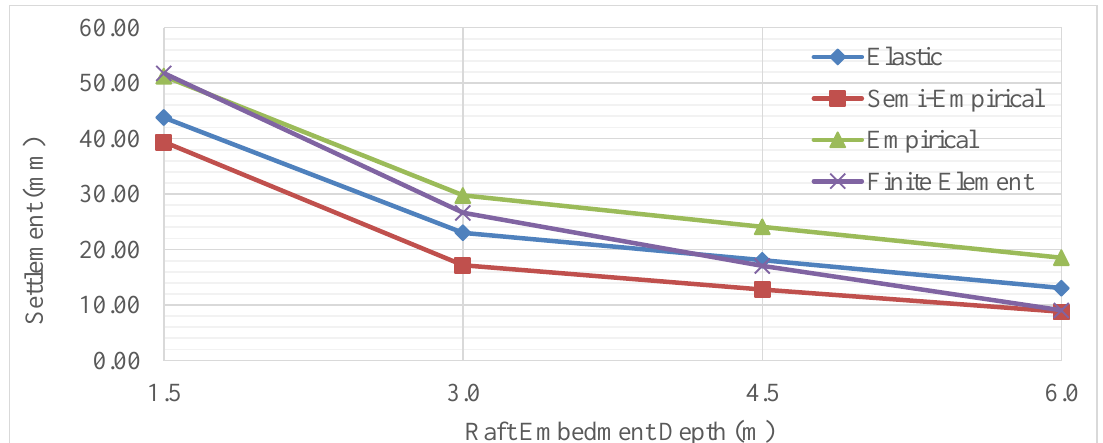
Fig. 6. Settlement versus embedment depth for 200 kN/m 2 applied